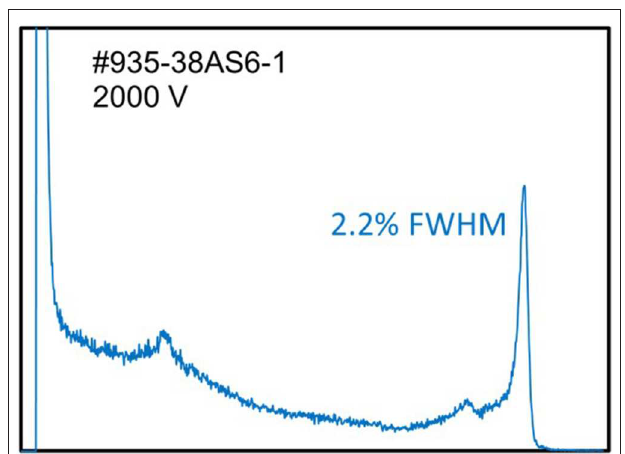
with 0.5 mm pitch for the top strips and 2.5 mm pitch for the bottom strips.